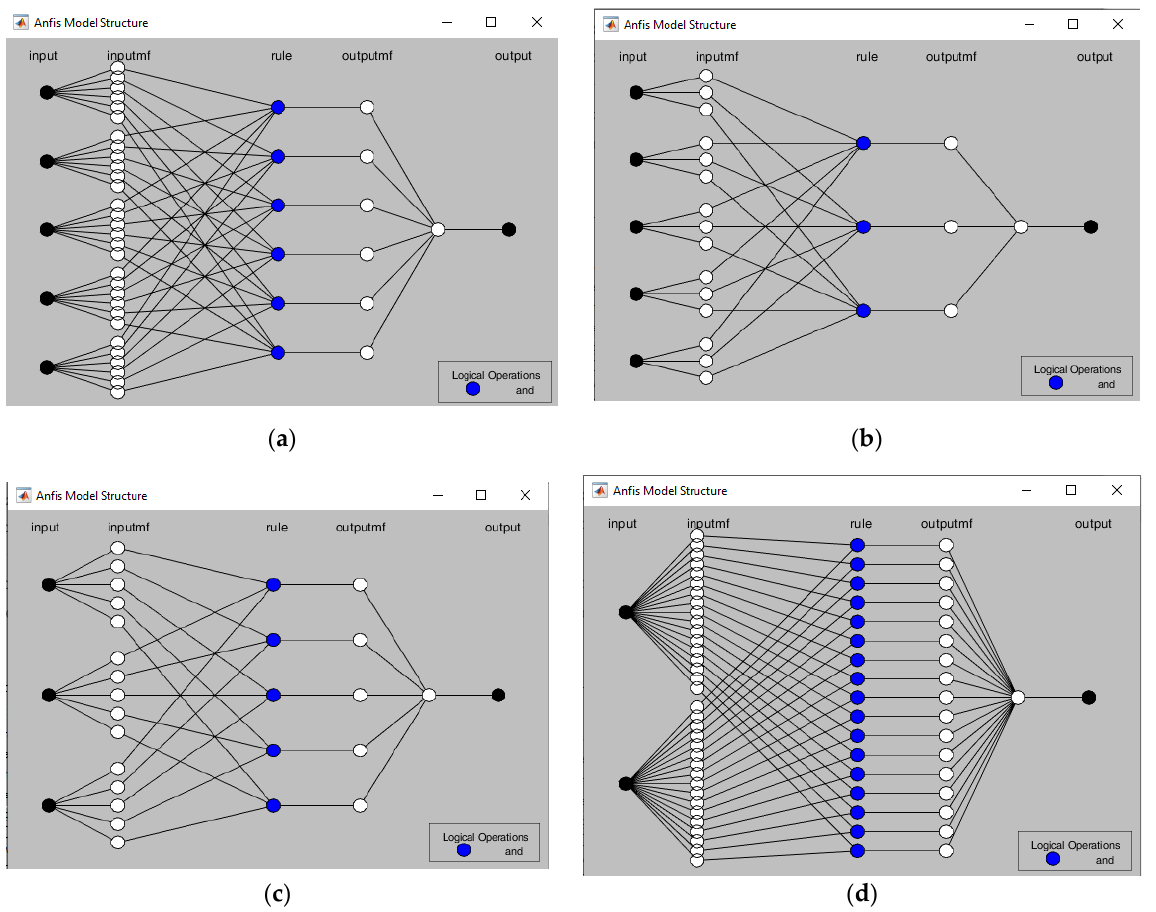
Figure 11. Different architectures of the ANFIS models using subtractive clustering method; ( a ) N = 5, IR = 0.1; ( b ) N = 5, IR = 0.5; ( c ) N = 3, IR = 0.2; ( d ) N = 2, IR = Table 2. Results of modelling and prediction using ANFIS subtractive clustering.